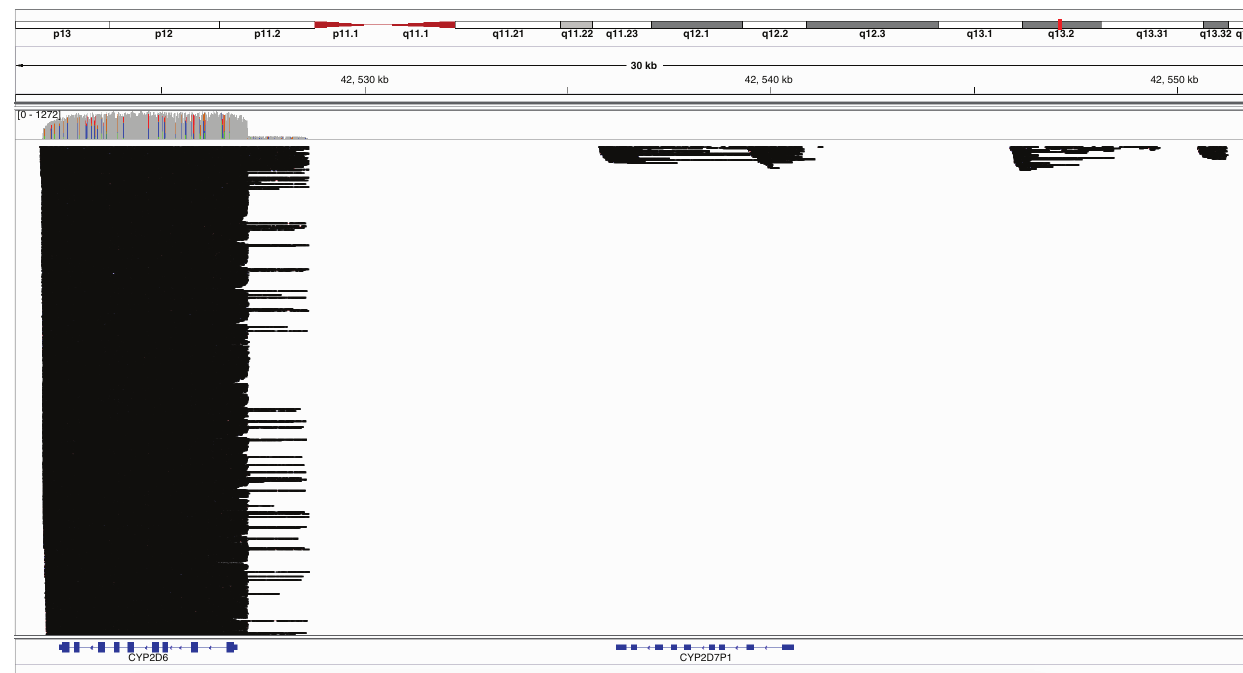
Figure 1. Integrate Genomics Viewer (IGV) diagram of MinION reads aligned to the CYP2D locus on chromosome 22 from 42,521,411 to 42,552,401. The majority of reads aligned across the entire length of CYP2D6 as was expected by selective PCR amplification. Downstream, an insignificant number of read fragments aligned to CYP2D7 and CYP2D8 ( 2D8 is located from 42,545,874 to 42,551,097; exon-intron diagram not shown in gene annotation track). Due to the extremely high coverage at CYP2D6 , not all reads are shown in this pileup diagram.